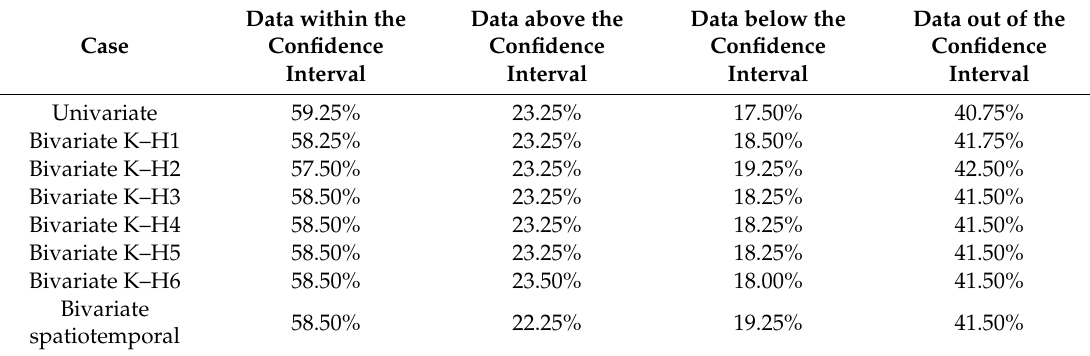
Figure 6. Hydraulic conductivity estimate error variances. Table 7. Analysis of K estimates within the confidence